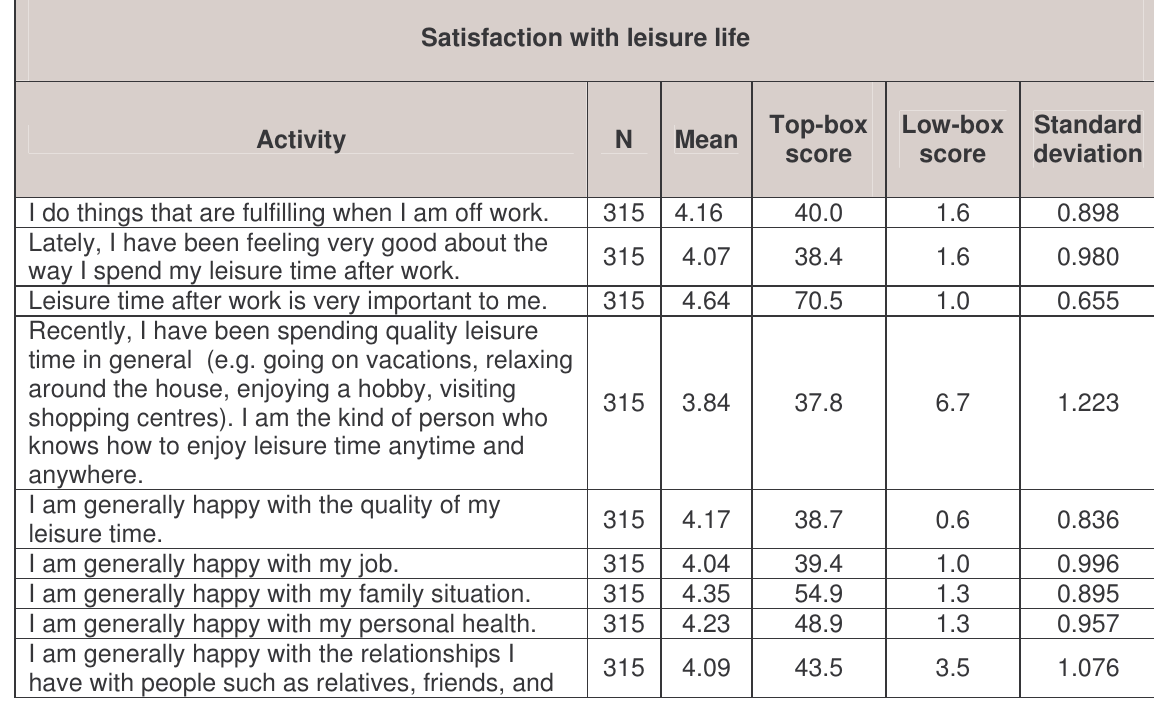
Table 5: Satisfaction with leisure